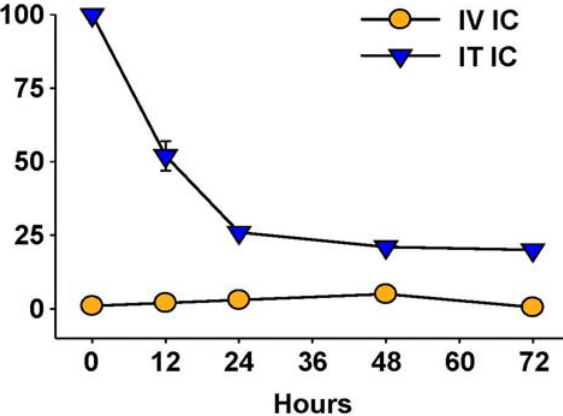
Figure 5. IT vs . IV delivery results in increased tumor retention of IC . CEA-transgenic C57BL/6 mice bearing d10 s.c. MC-38.CEA tumors were treated with 111 In-GcT84.66-IL2 anti-CEA IC. Animals received 25 μ g IV (5/grp) or 2.3 µg IT (2/grp). Tumors